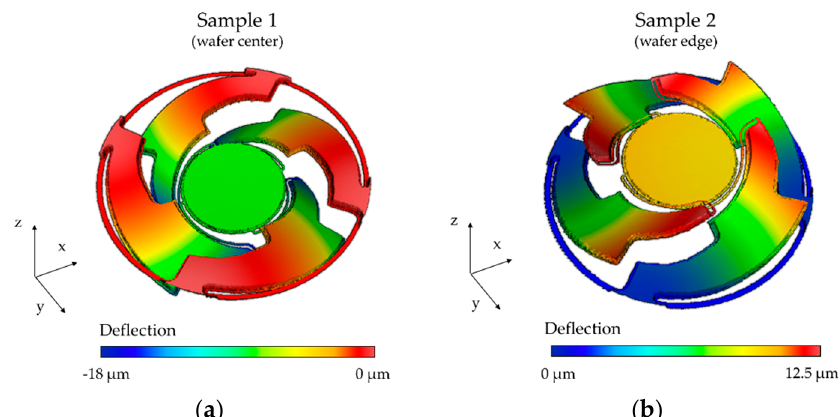
Figure 15. Topological area scans of Design 1 performed using white light interferometry: ( a ) wafer center (Sample 1); ( b ) wafer edge (Sample 2).